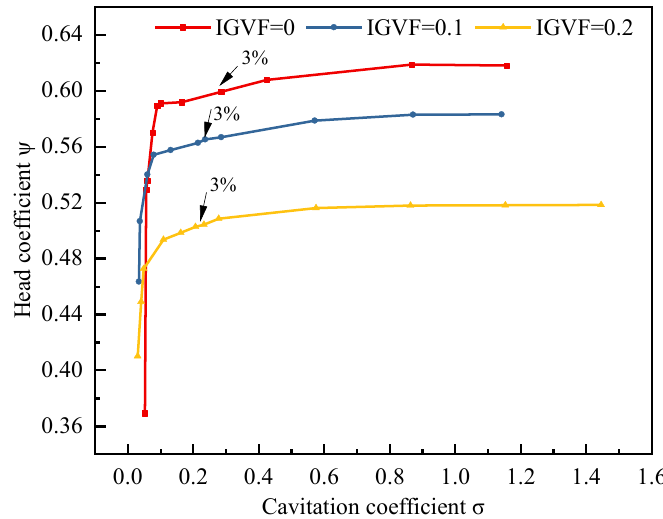
Figure 6. Cavitation characteristics.